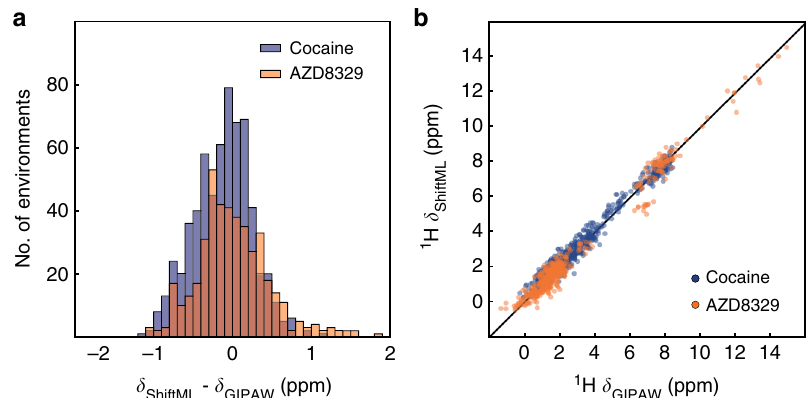
Fig. 4 Comparison of predictions from ShiftML and GIPAW DFT for polymorphs of cocaine and AZD8329. a Histogram showing the distribution of the differences between 1 H chemical shifts calculated with GIPAW and with ShiftML for the polymorphs of cocaine (blue), and the polymorphs of AZD8329 (orange). b Scatterplot showing the correlation between 1 H chemical shifts calculated with GIPAW and ShiftML for cocaine (blue) and AZD8329 (orange). The black line indicates a perfect correlation